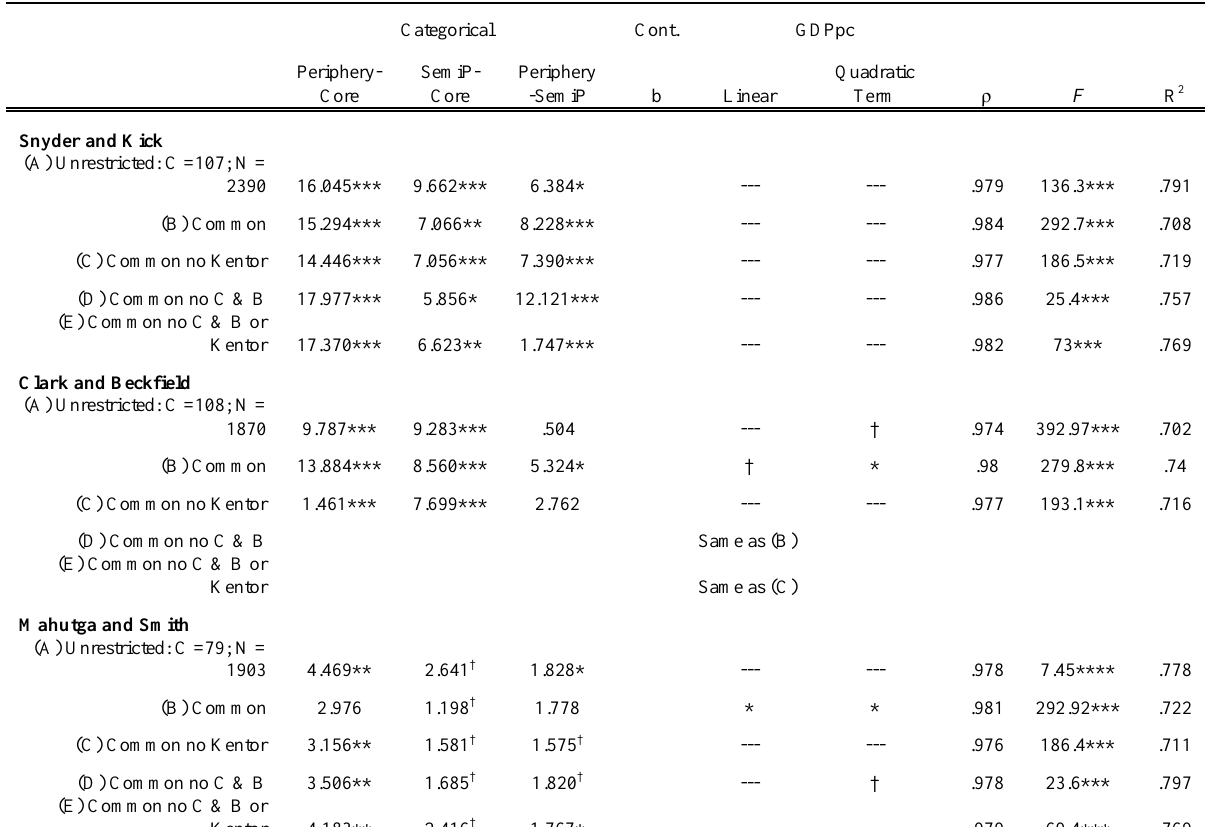
Quadratic Term ρ F R